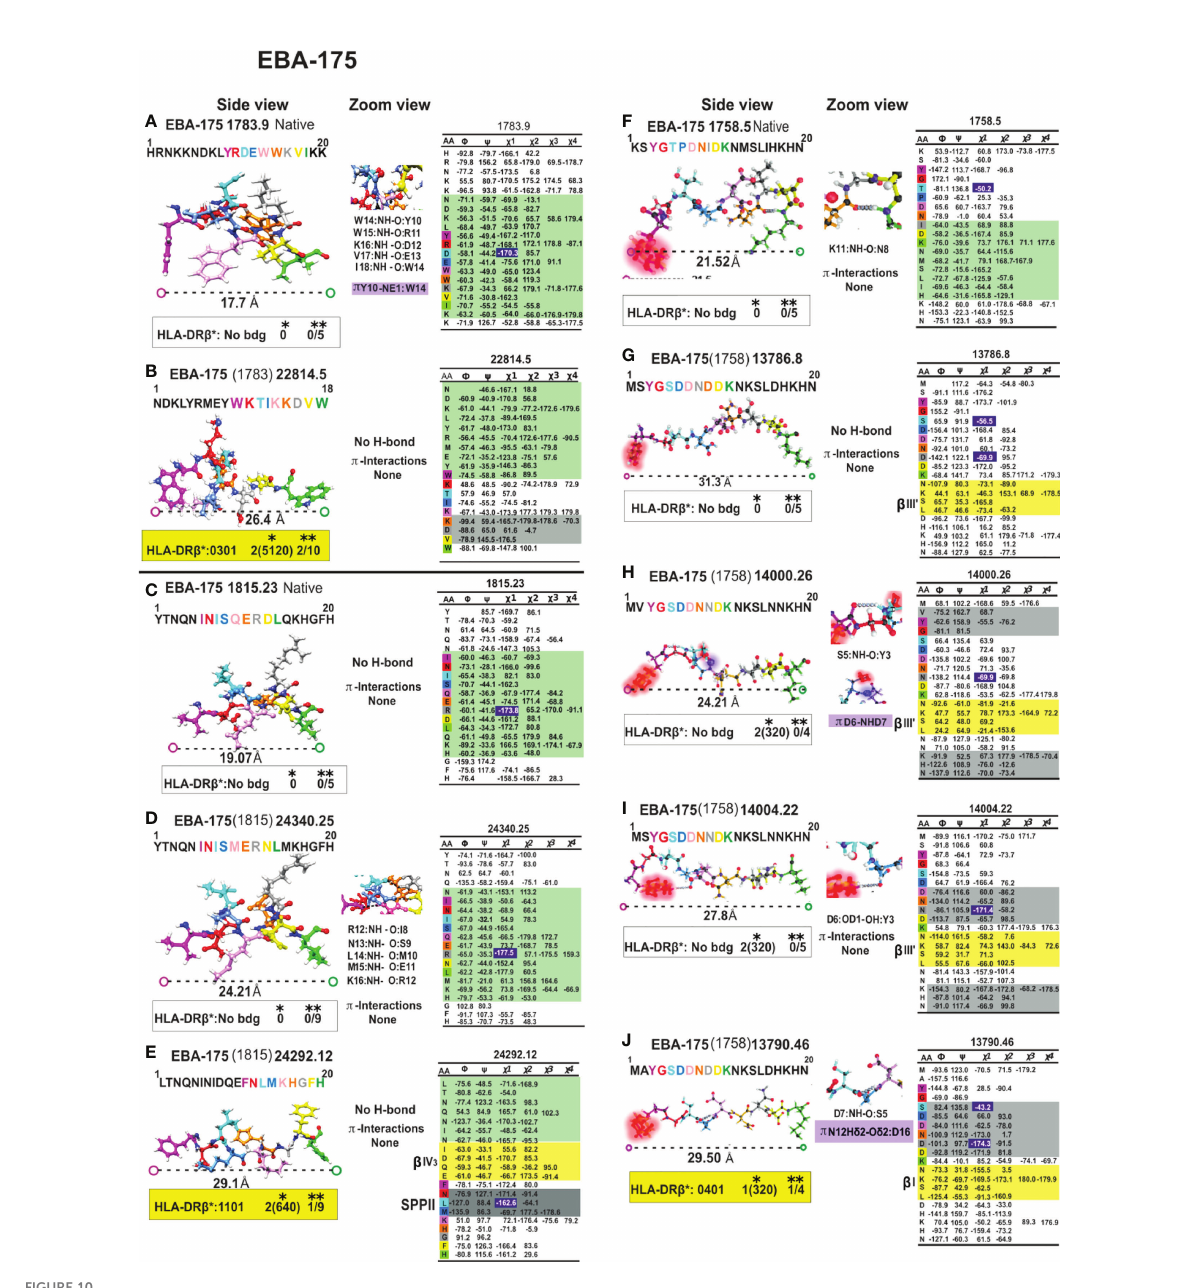
FIGURE 10 Colour code for peptide binding region, structural and interaction as in Figure 8. (*) Nr Monkeys (antibody titers) and (**) Nr of protected monkeys. EBA-175-derived cHABPs and mHABPs. Legend and conventions as in Figure